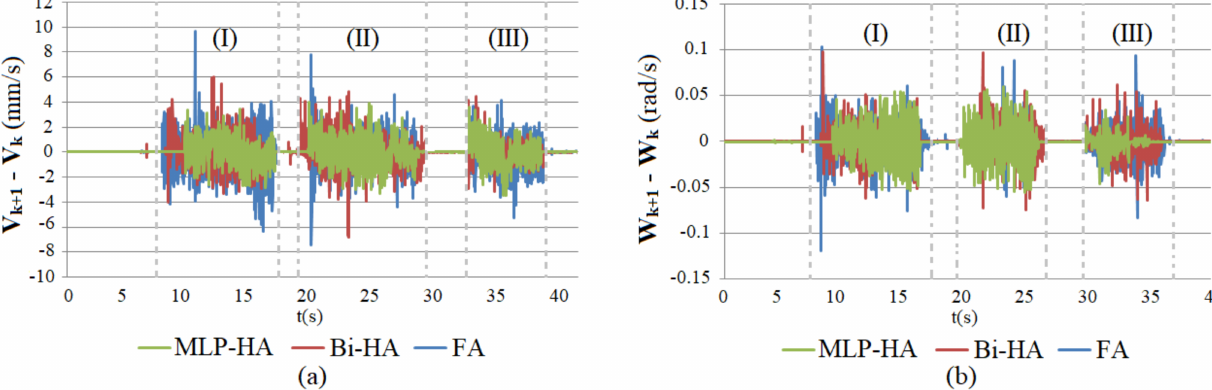
Figure 13. The variation of end-effector during teaching task, ( a ) the variation of linear velocity (mm/s), ( b ) the variation of angular velocity (rad/s). Here, MLP-HA is the proposed MLP-HA-based admittance controller, Bi-HA is Bi-HA-based admittance controller, and FA is a fuzzy-based admittance controller. MLP-HA-based admittance controlleris found to provide better cooperation compared to other